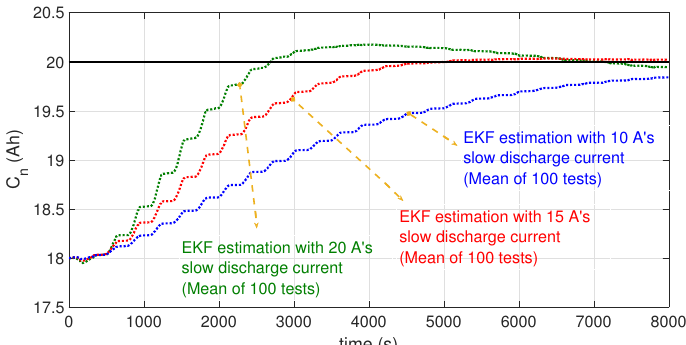
Figure 10. Battery input current level effect on battery capacity